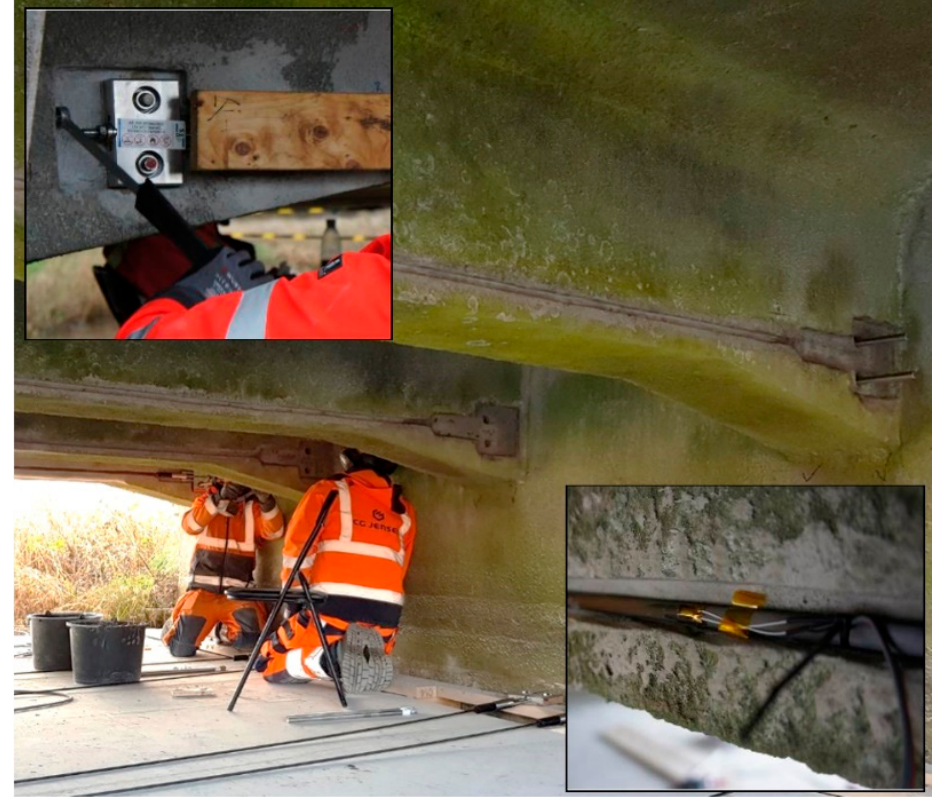
Figure 16. Site installation of the throughgoing threaded bar and pre-stressing of the system. Pho- tograph by S&P.